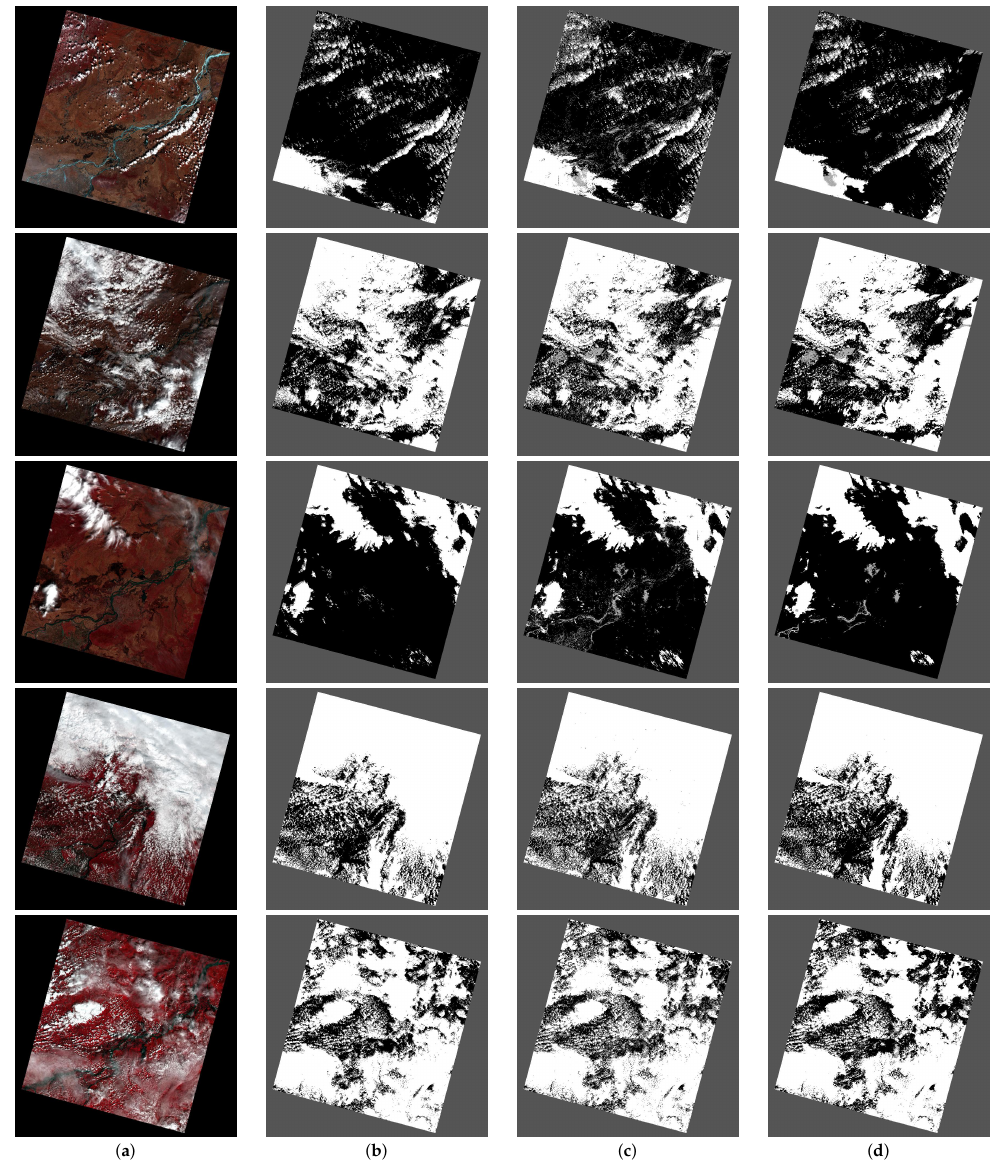
Figure 8. Examples of segmentations with or without Dense CRF refinement (L8, Path 113, Row 26): ( a ) false-color image; ( b ) reference; ( c ) UNet × α ; and ( d ) UNet × α + Refinement. Bands 5 NIR, 4 Red, and 3 Green are combined together as RGB channels to construct a false-color image for visualization. The refinement of Dense CRF can precisely delineate the boundaries of clouds and shadows; in addition, it can remove the isolated classification errors and smooth the gaps caused by slice-wise